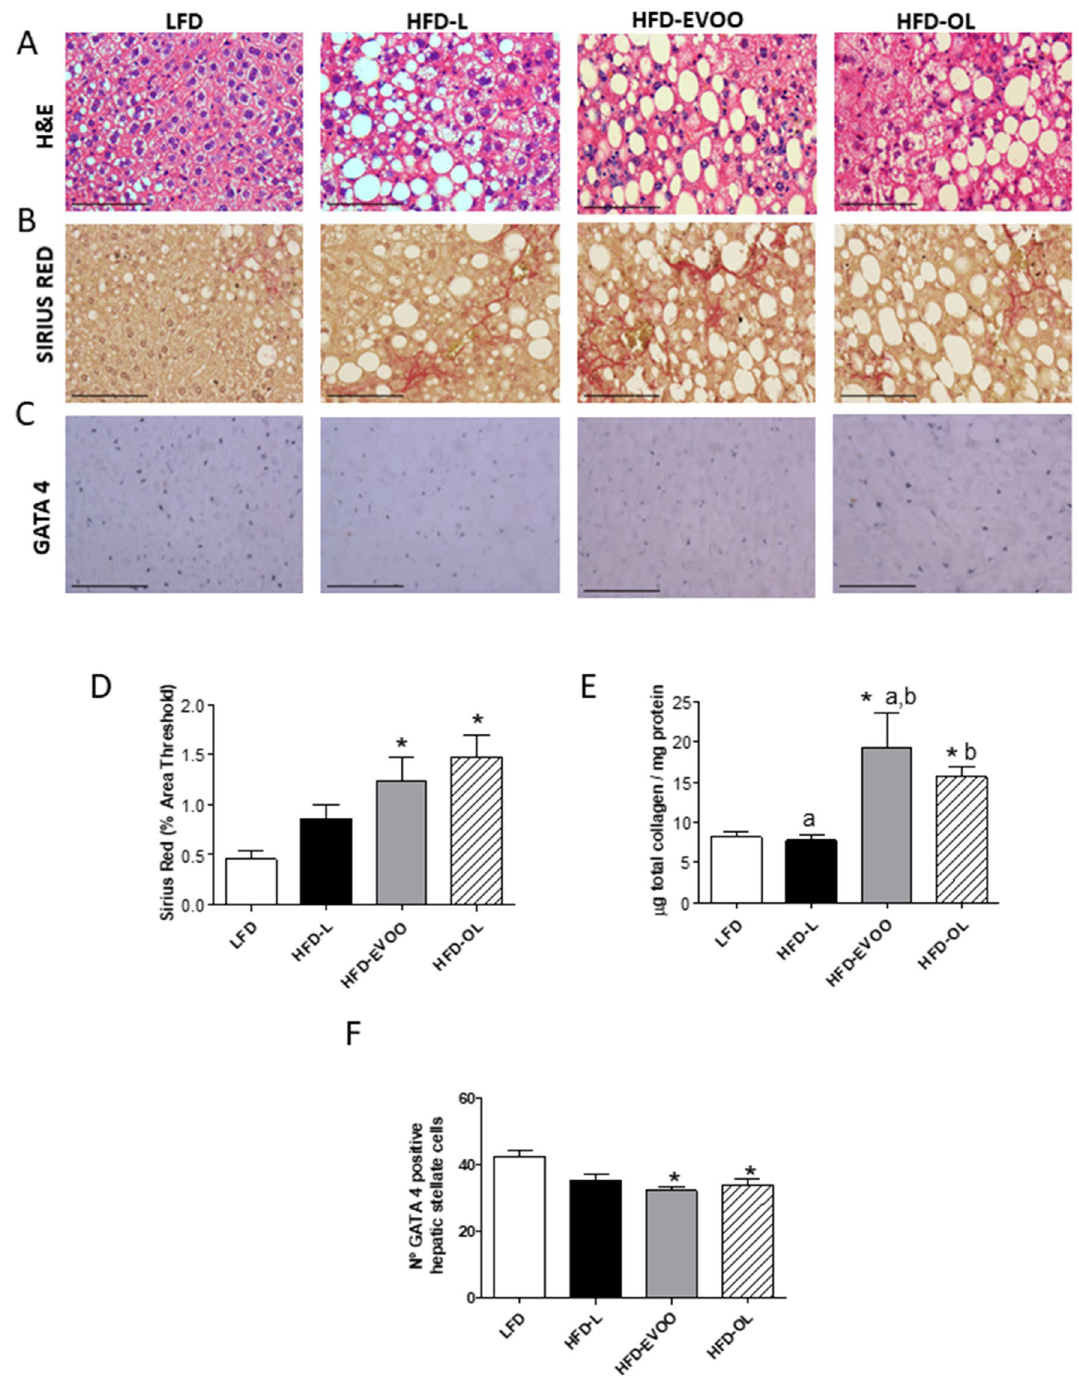
Figure 5. Liver stains after 32 weeks of nutritional intervention study. ( A ) H&E staining (40 ×). ( B ) Sirius Red staining (40 ×). ( C ) GATA 4 staining (40×). ( D ) Quantification of hepatic fibrosis by Sirius Red. ( E ) Quantification of total liver collagen (µg /mg liver protein) in liver homogenates. ( F ) Quantification of positive HSC per field. Values represent the means ± SEM (n = 10). *p < 0.05 LFD vs HFDs groups; different letters indicate significant differences between HFD groups ( p < 0.05). Scale bars = 100